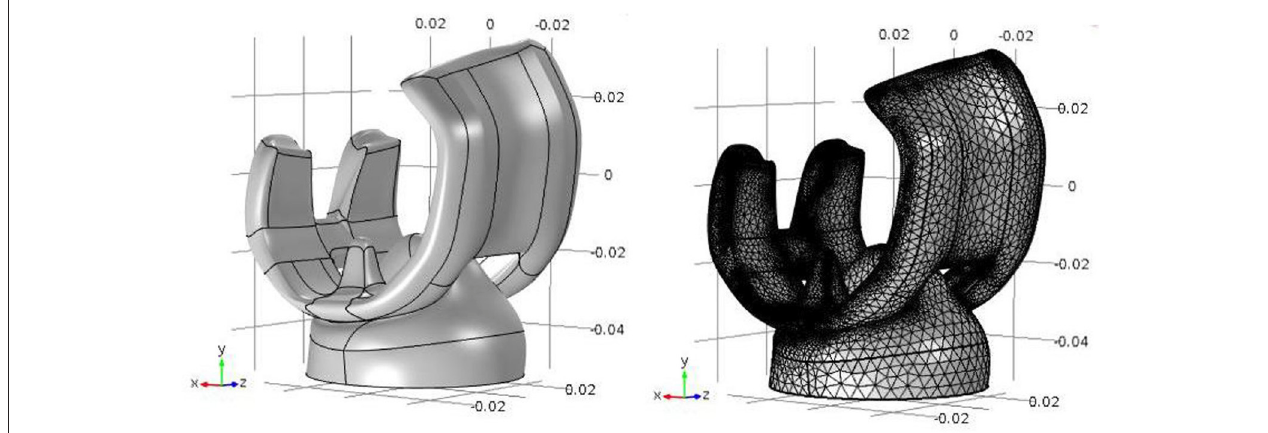
FIGURE 2 | The geometry (left) and the generated mesh (right) for finite element analysis.